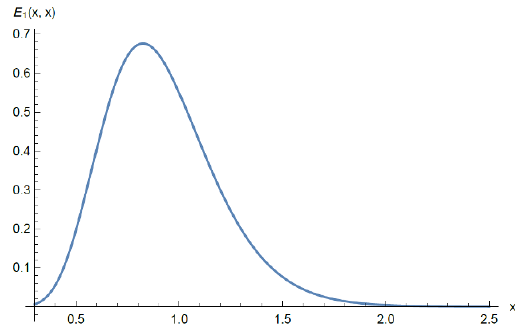
Figure 2 . The form of the symmetric function E 1 ( x; x ).